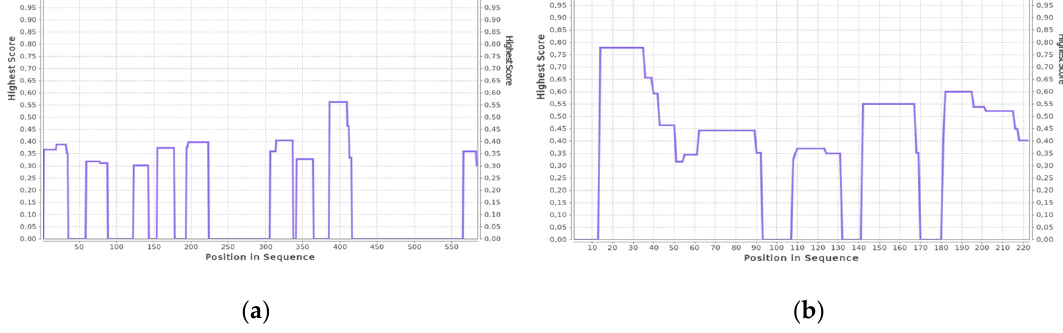
Figure A1. Prediction of amyloidogenic regions (denoted by blue contours) in the unfolded HSA ( a ) and trypsin ( b ) by using the ArchCandy program.